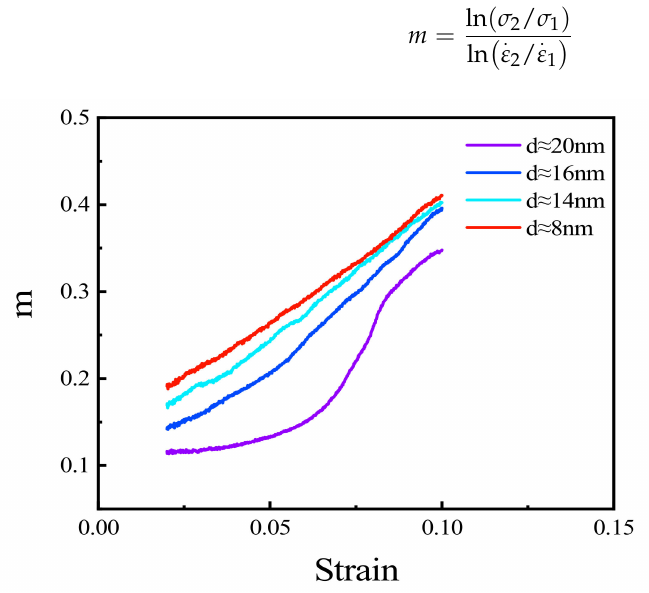
Figure 9. Strain rate sensitivity of polycrystalline Cu 6 Sn 5 with varying grain